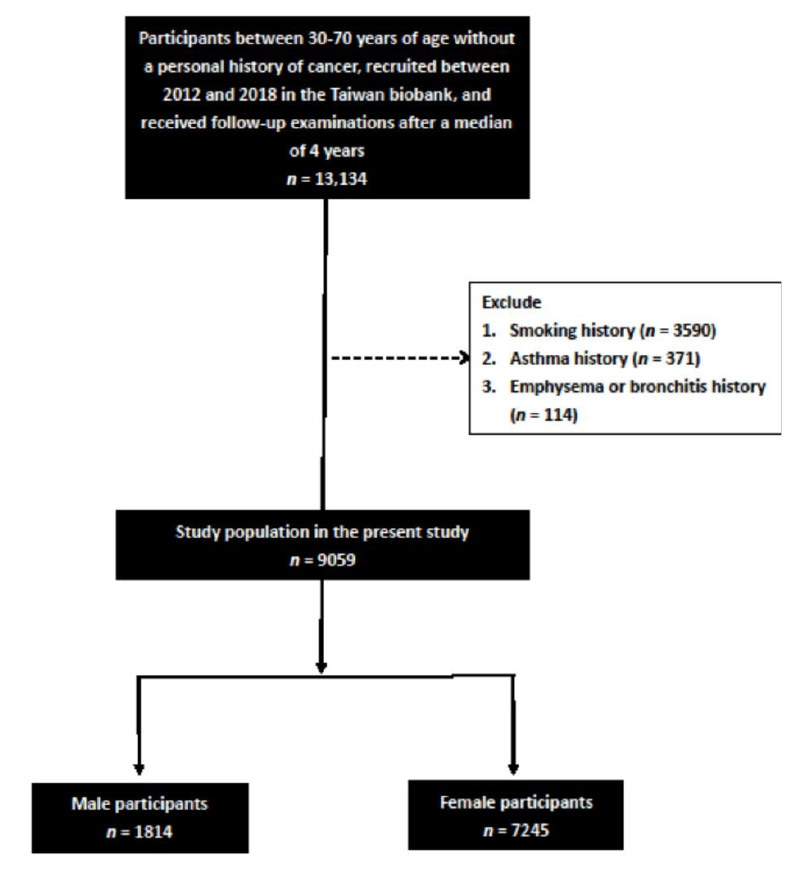
Figure 1. Flowchart of study